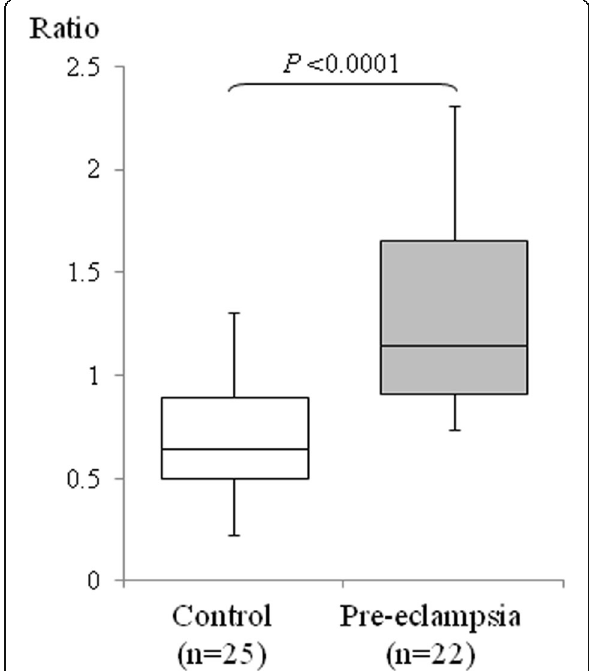
Fig. 1 Quantitative PCR analysis of NECTIN4 . Data were compared for uncomplicated normotensive pregnancy (open bars) versus severe pre-eclampsia (grey bars). The boxes indicate the 25th and 75th percentiles, whilst the bands near the middle indicate the median values. The bars indicate 1.5 interquartile ranges with the outliers specifically marked (x)